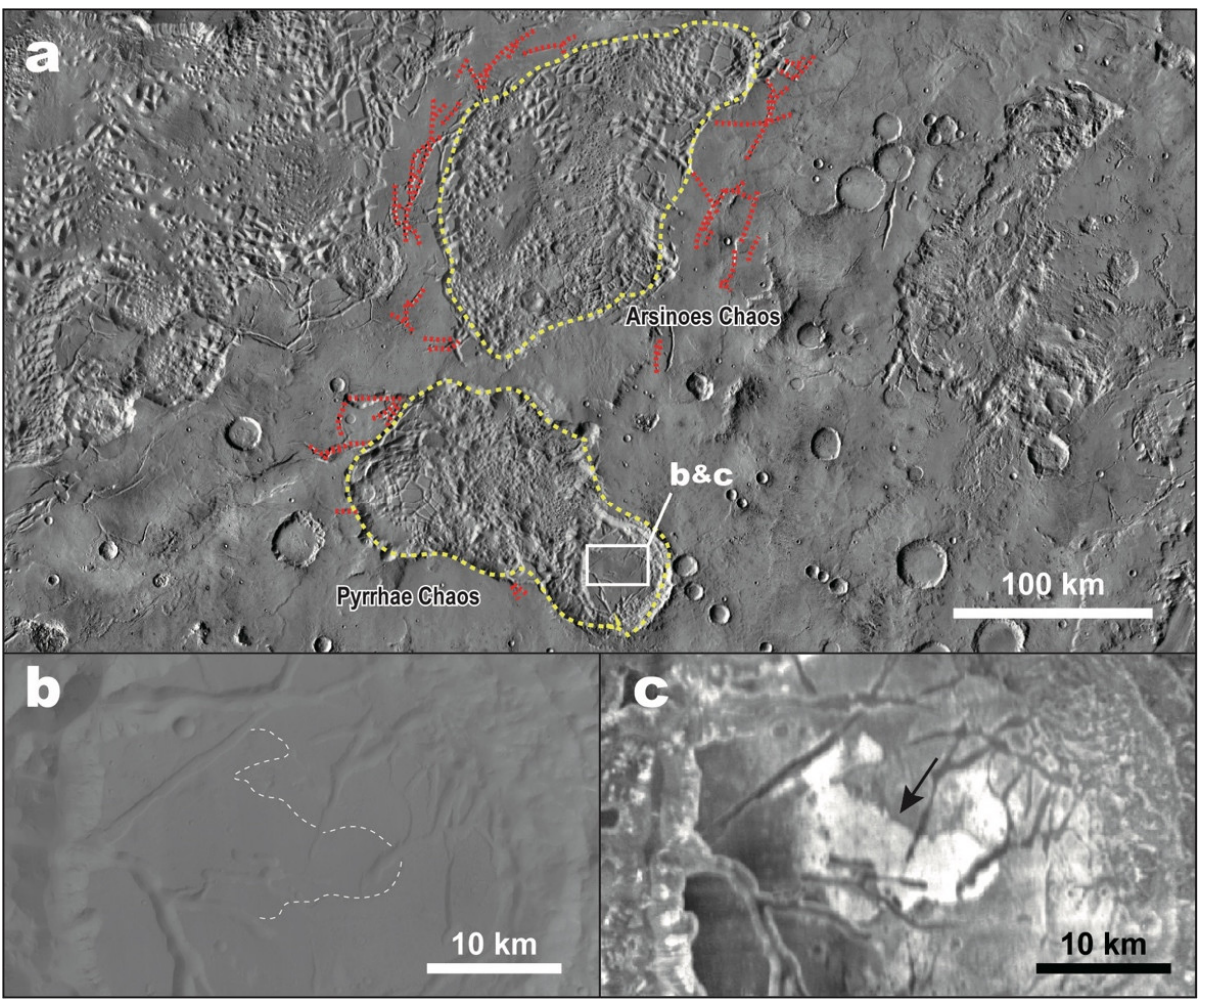
Figure 3. ( a ) A THEMIS daytime infrared image of Arsinoes Chaos and Pyrrhae Chaos. The areas surrounded by the yellow dotted lines indicate the chaos terrains. The red dotted lines indicate faults and elongated graben-like depressions possibly formed by volcanic activity [5,6]. The white box indicates the locations of lava flows shown in panels ( b , c ). ( b ) A close-up CTX image of lava flows. The white dotted line indicates the outline of lava. ( c ) A close-up THEMIS thermal inertia image of lava flows. The black arrow indicates the lava flow with high thermal inertia.